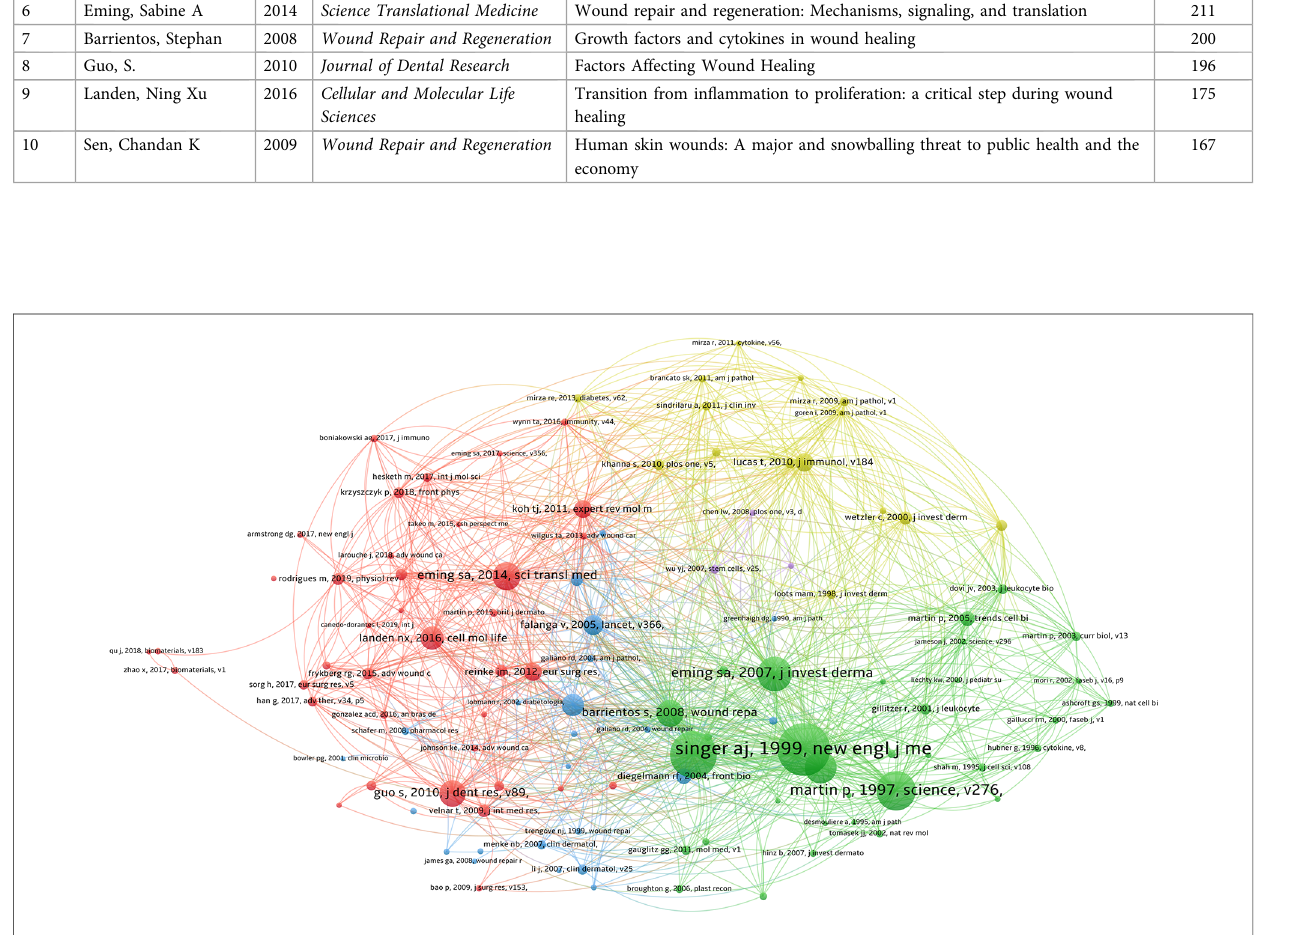
FIGURE 6 Co-citation analysis of references. The most cited article in co-citation analysis were written by A. J. Singer. Clusters of the same color indicate that the literature studies are related or have some